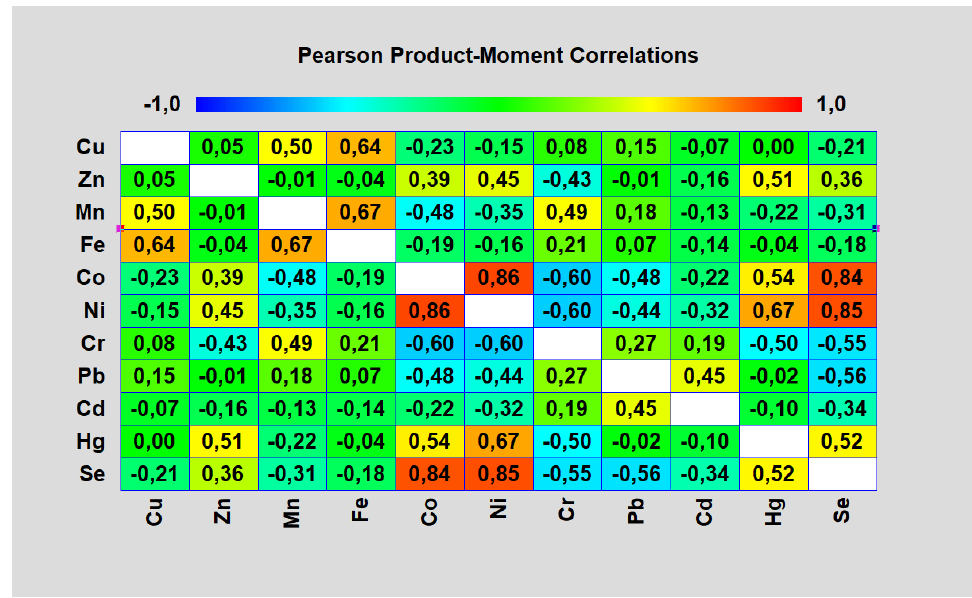
Figure 4. Pearson product moment correlations-selenium fortified variant (Source: Author of the work). p -values below 0.05 indicate statistically significant non-zero correlations at the 95.0% confidence level. The following pairs of variables have p -values below 0.05. Cu and Mn, Cu and Fe, Zn and Co, Zn and Ni, Zn and Cr, Zn and Hg, Zn and Se, Mn and Fe, Mn